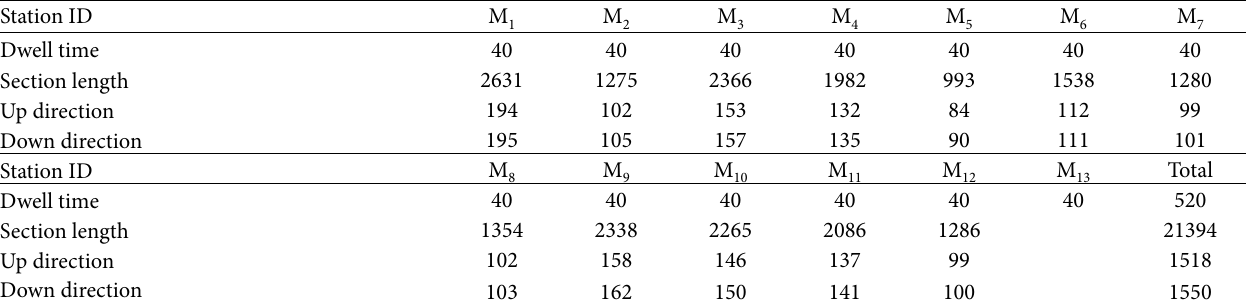
Table 7: Input data of Yizhuang line in Beijing.